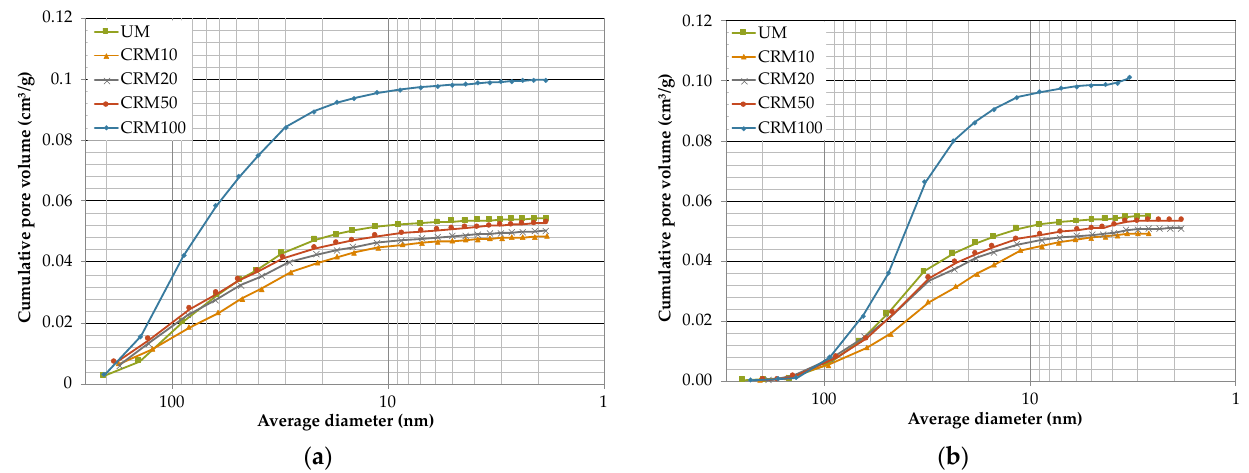
Figure 7. Pore size distribution with respect to cumulative pore volume: ( a ) adsorption phase; ( b ) desorption phase. Regarding the size distribution (diameter) of pores defined by IUPAC (International The above graphs provide the porosity of the CRMs, which is expressed as cumula- Union of Pure and Applied Chemistry), pores can be classified into: micropores (pore < 2 nm), tive pore volume (cm 3 /g) and are presented in Table 5. The above porosity values have a similar trend to the values obtained by means of the open porosity test (Table 4). By the N 2 adsorption technique, the average superior difference of CRM100 with respect to the